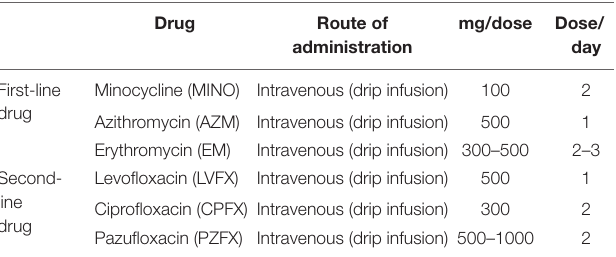
The table is adapted from the guiding principle of JSM (http://square.umin.ac.jp/